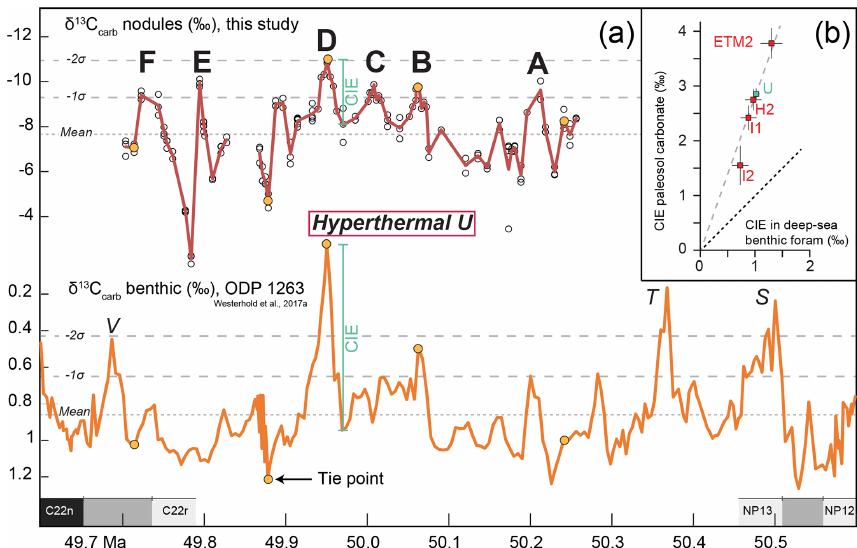
Figure 7. (a) Scaling of the Chiriveta isotopic section with the time equivalent interval of site 1263 (Westerhold et al., 2017). The correlation was calculated using the AnalySeries software (Paillard et al., 1996) and centred on CIE D and hyperthermal U. Mean, minus 1 and 2 SD lines on the global record were calculated sets over the selected time period. The correlation coefficient ( r ) between the two curves is 0.65. (b) Hyperthermal U amplitude in palaeosol carbonate and benthic foraminifera (inset B after Abels et al., 2016).